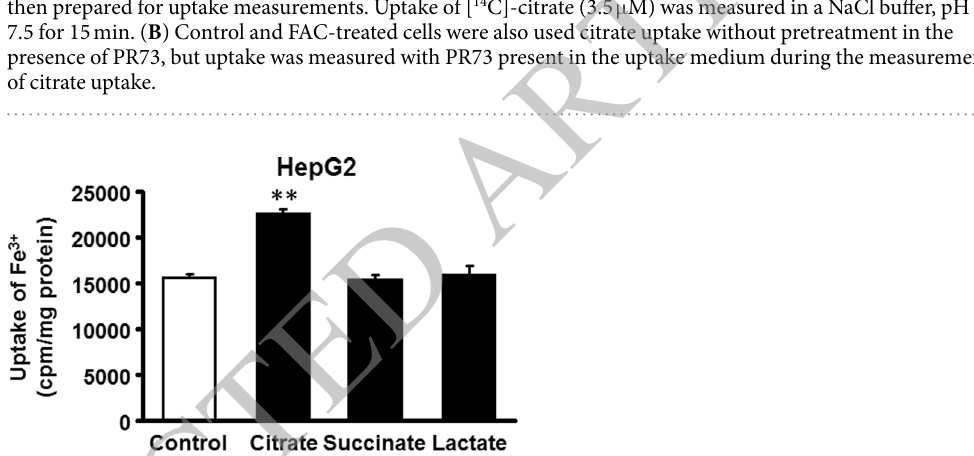
Figure 7. Stimulation of Fe 3 + uptake by citrate in HepG2 cells. Uptake of [ 59 Fe]-FeCl 3 was measured in HepG2 cells in NaCl buffer, pH 7.5 (15 min incubation) in the absence or presence of 50 μ M citrate, succinate or lactate. The results are expressed as counts/min/mg of protein. ** p <